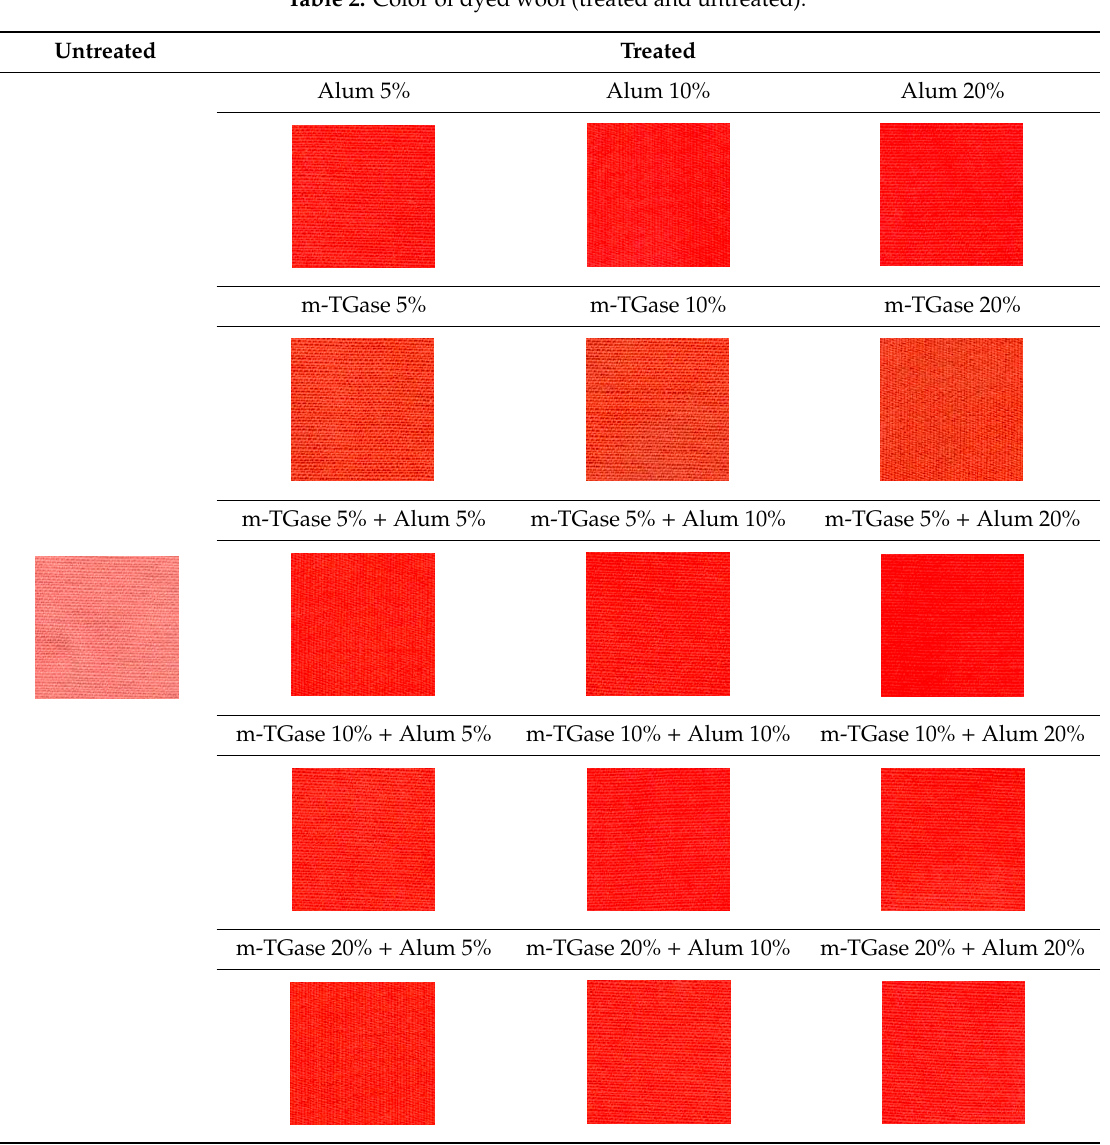
Table 3. Variation of color fastness under different treatments .